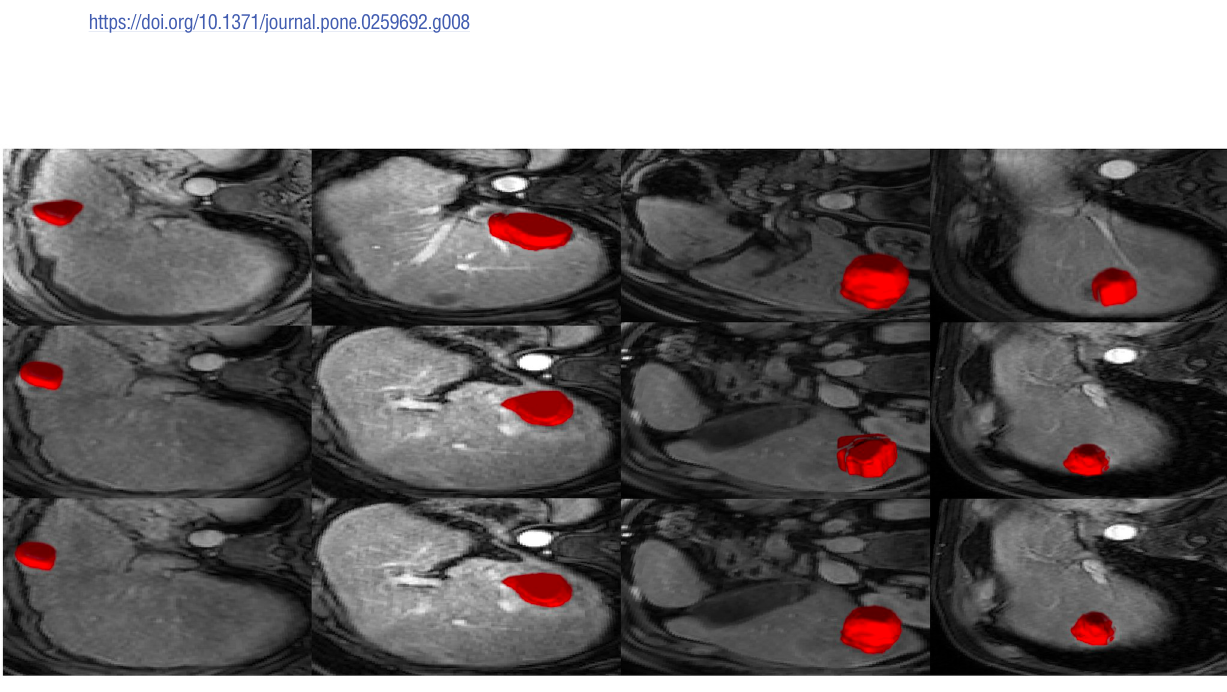
Fig 9. Pre-TACE (used as input) and post-TACE images with HCC segmentations generated through the decoder for 4 different liver cancer patients. The first row depicts the pre-TACE examination with HCC delineation used as the baseline input. The second row presents the ground-truth post-TACE examinations, while the third row presents the predicted post-TACE